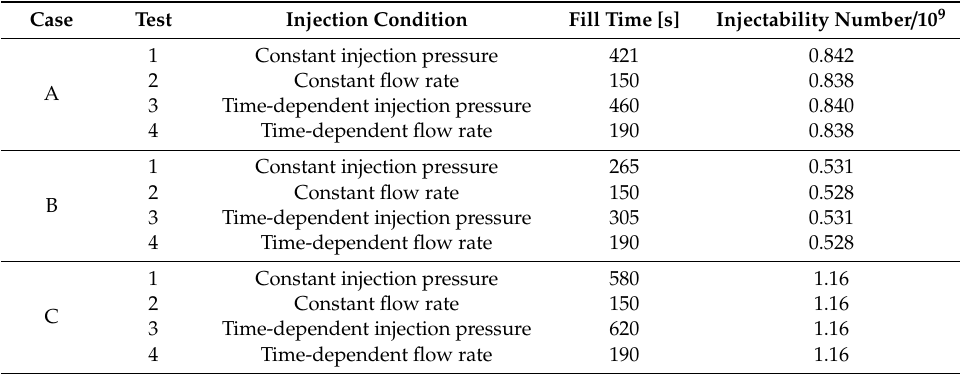
Table 2. Fill times and injectability numbers for injection cases through a point inlet.